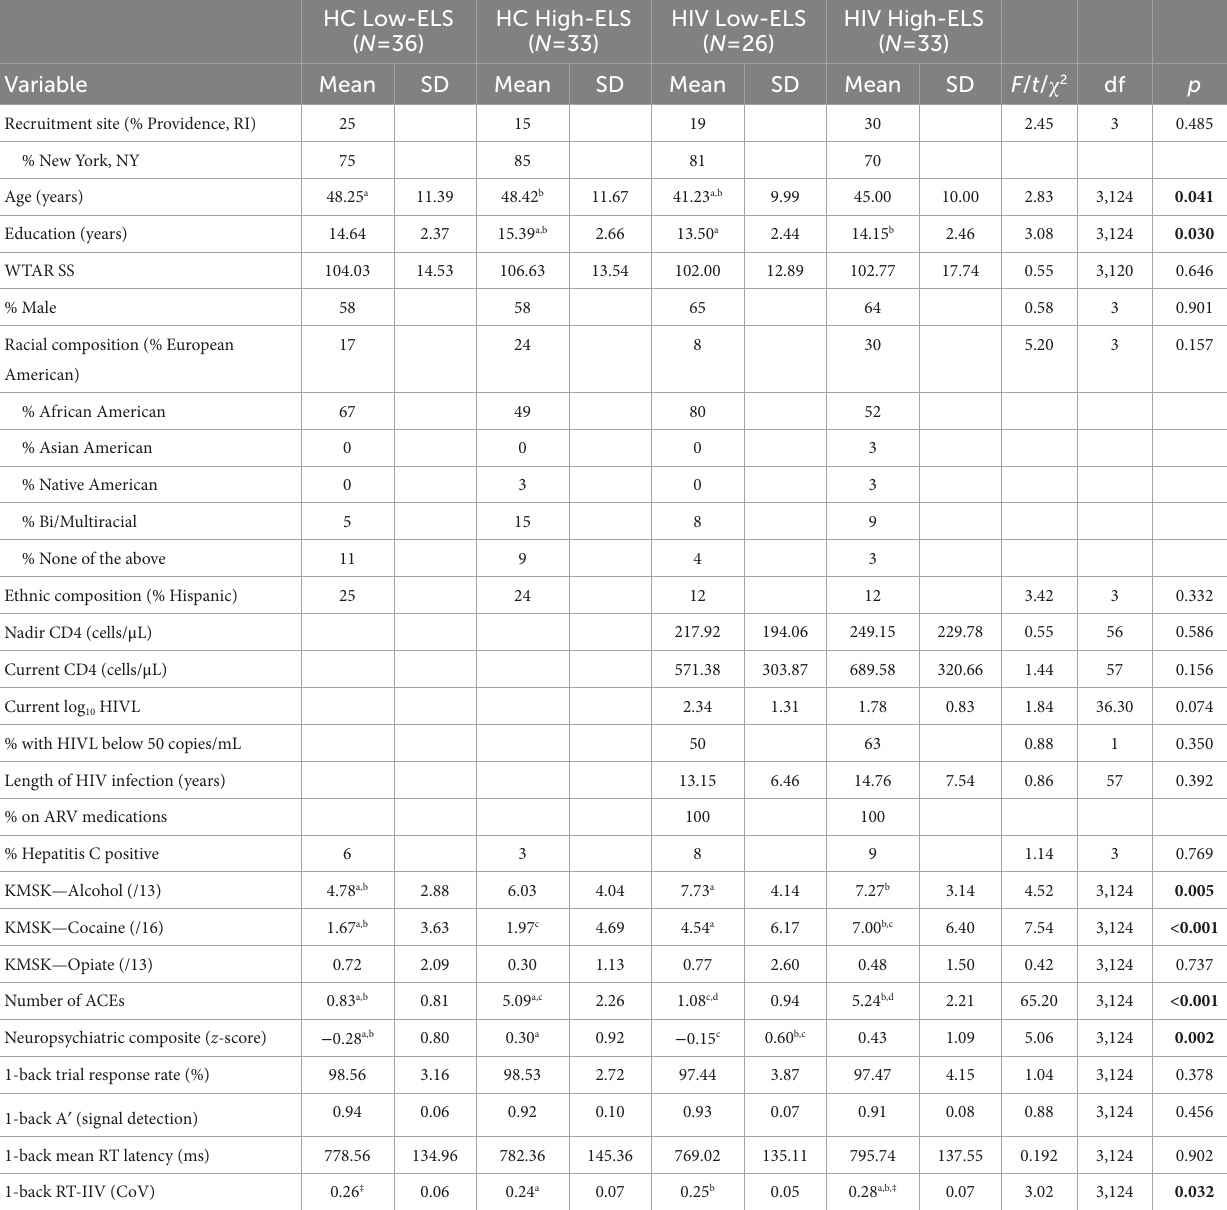
TABLE 1 Demographic, neuropsychiatric, and cognitive characteristics of the participant